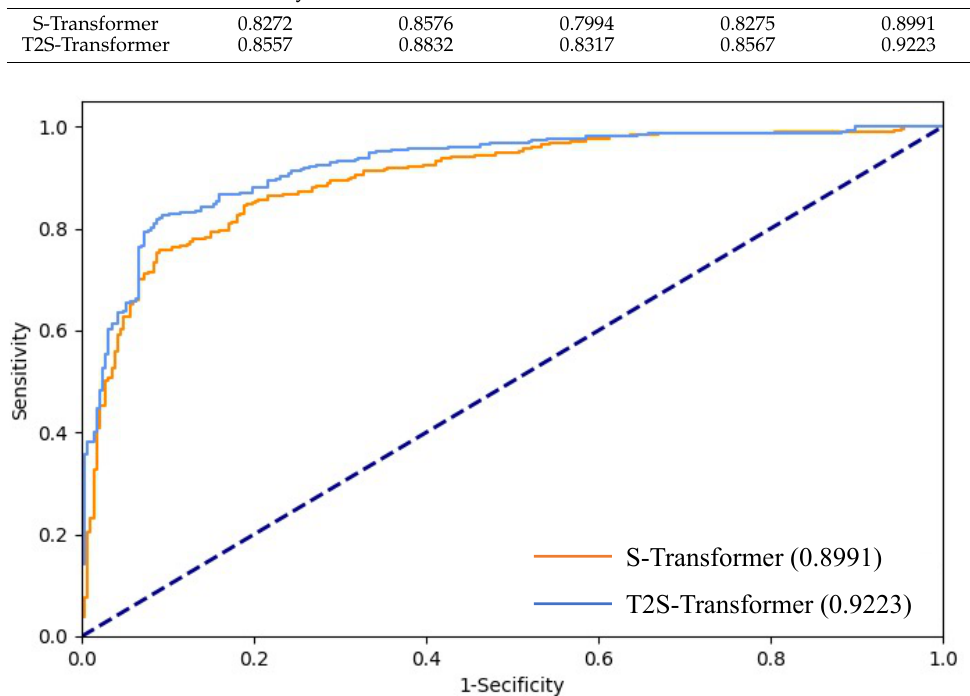
Figure 4. Receiver operating characteristic (ROC) curves of the proposed T2S-Transformer and the naive S-Transformer. Numbers in parentheses show the AUC values of the two